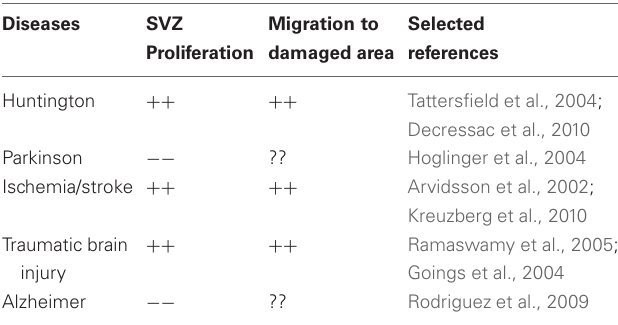
Table 1 | In different neurodegenerative diseases SVZ proliferation either increases ( ++ ) or decreases ( −− ).